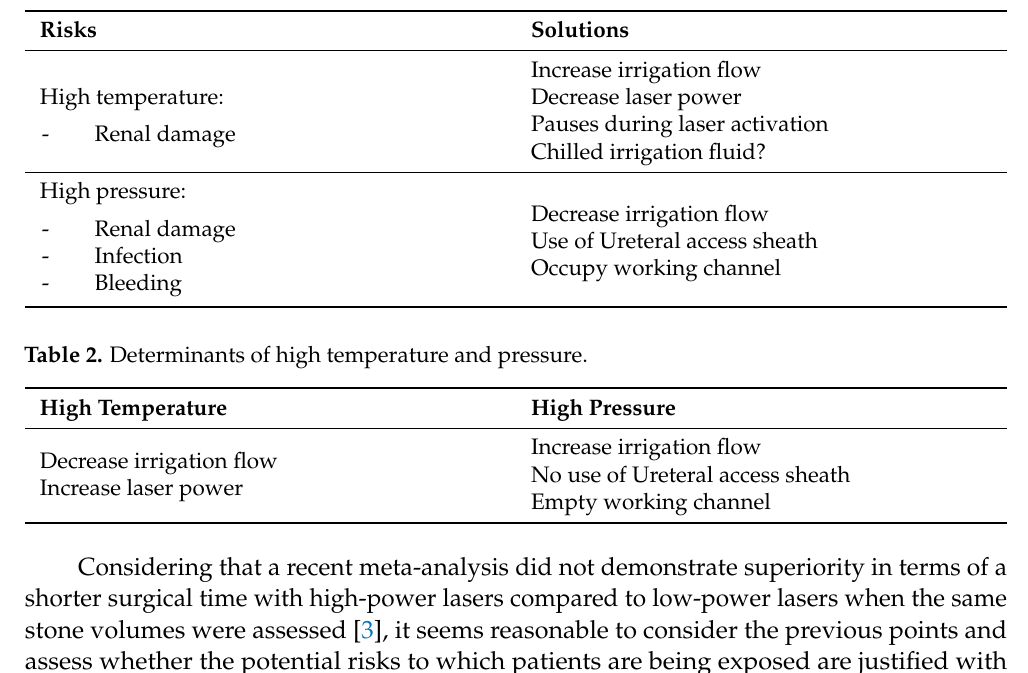
Table 1. Summary of risks and potential solutions.